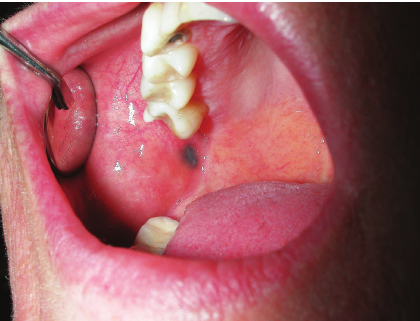
Figure 2: Clinical photographs of the 2 × 2 mm pigmented lesion of the right buccal mucosa. Histopathological examination was consistent with amalgam tattoo in both lesions (see Figure